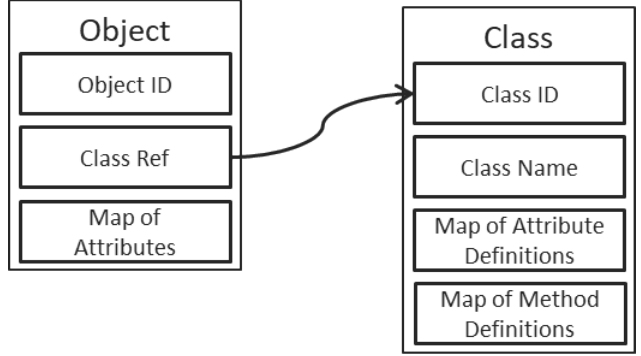
Figure 2. Structures of objects and classes in DOORS.